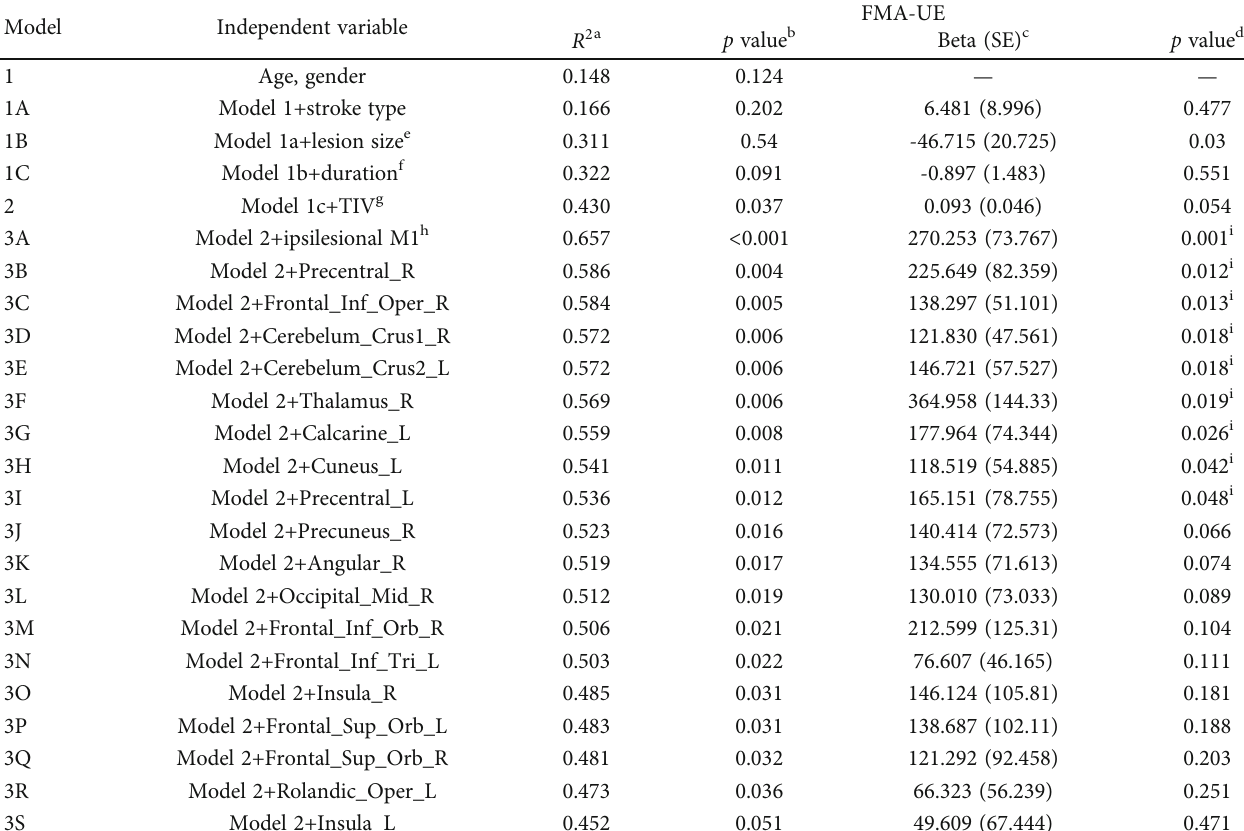
Table 4: Associations of regional GM volume with motor function in left-sided stroke patients.